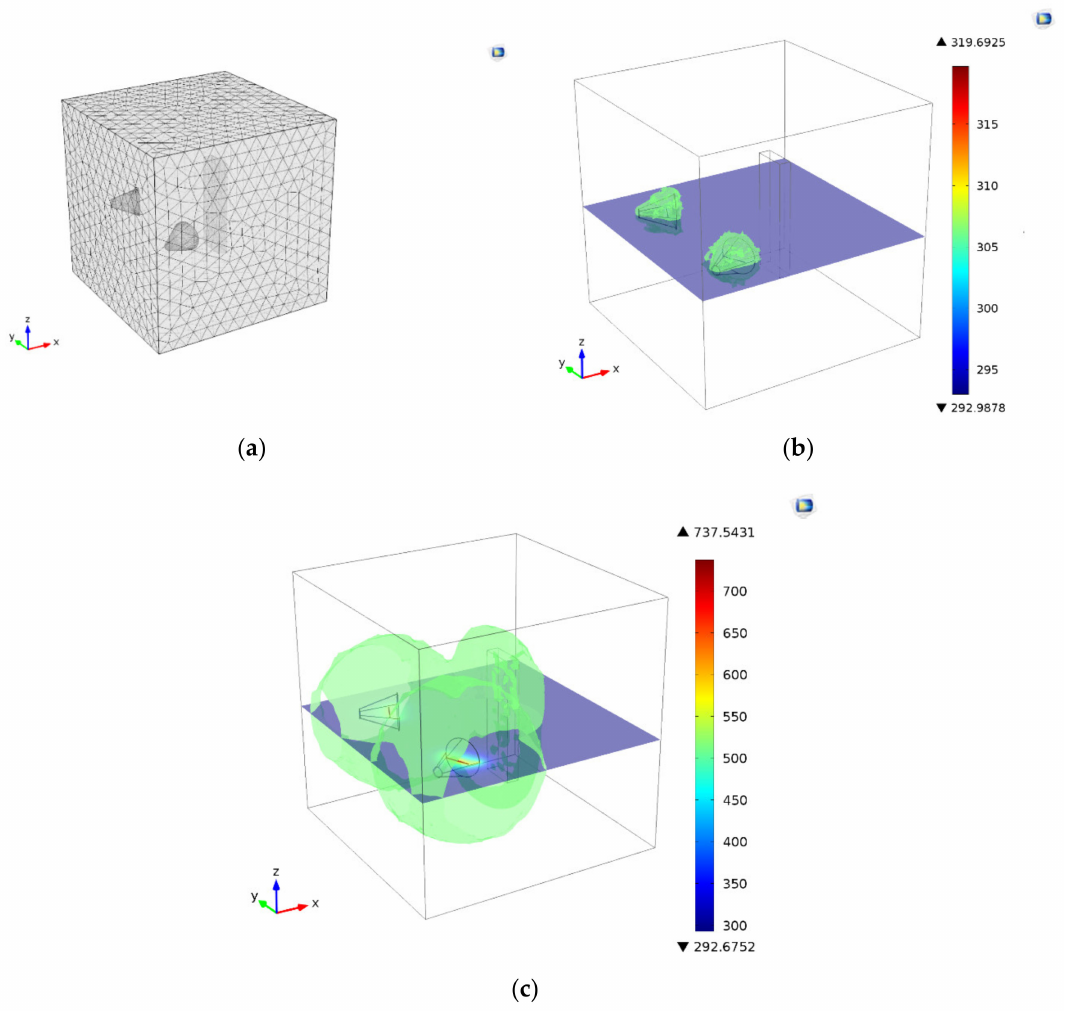
Figure 3. The first model allows us to evaluate the thermal distribution induced on the specimen: ( a ) image of the mesh; ( b ) image of the thermal distribution at the beginning of heating; ( c ) thermal distribution at 10